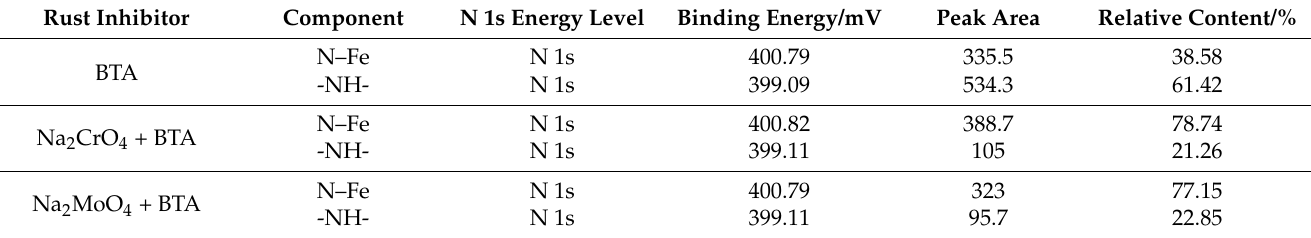
Table 5. Fitting data of N element in different test groups.